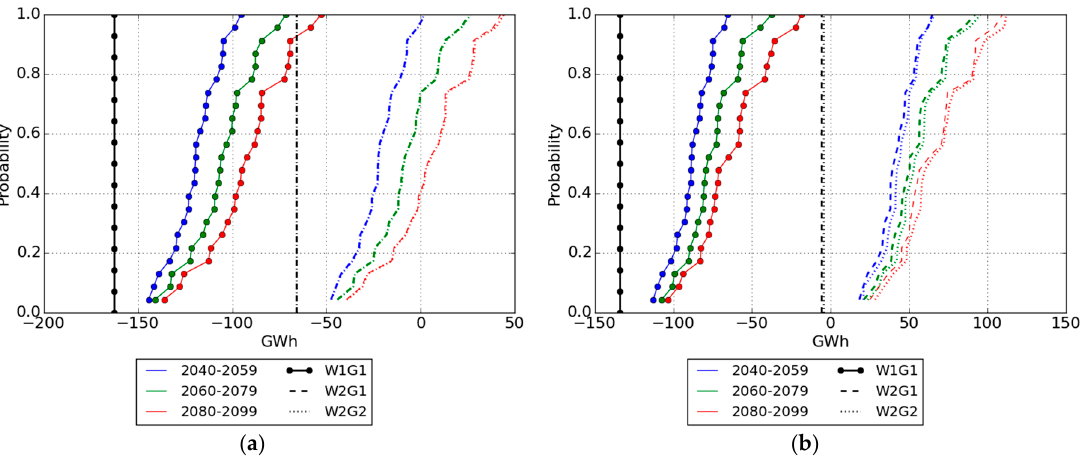
Figure 8 : Cumulative distribution function (CDF) of the weekly energy balance for the whole year (GWh) ( a ) and for the winter season ( b ) calculated from annual changes in precipitation and temperature provided by GCMs (blue: 2040–2059; green: 2060–2079; red: 2080–2099). Vertical solid dotted, dashed and dotted black lines shows energy balance values obtained under present climate for W1G1, W2G1 and W2G2 scenarios, respectively. Note that for the whole year, CDFs of W2G1 and W2G2 scenarios are overlapping.